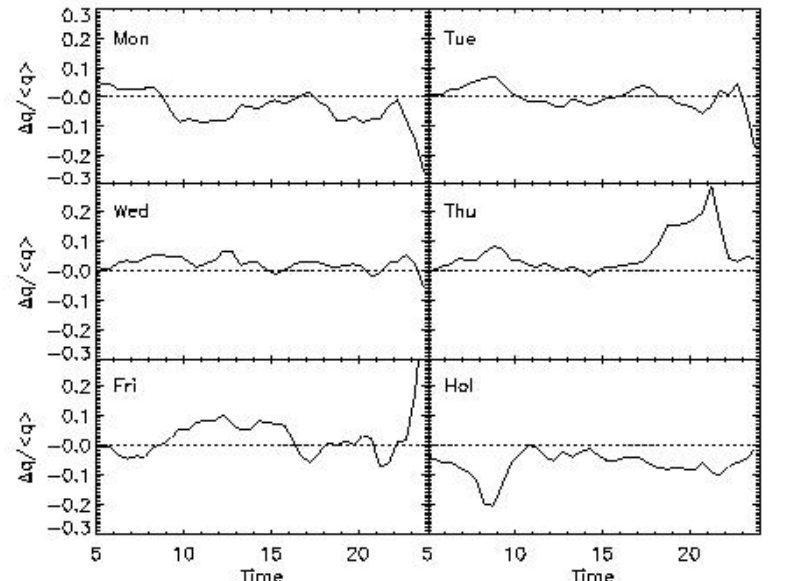
Figure 3. The relative difference between the mean profile per group and the mean profile over all groups. The groups are: Mondays (top left), Tuesdays (top right), Wednesdays (center left), Thursdays (center right), Fridays (bottom left) and Holidays (bottom right). The figure shows network